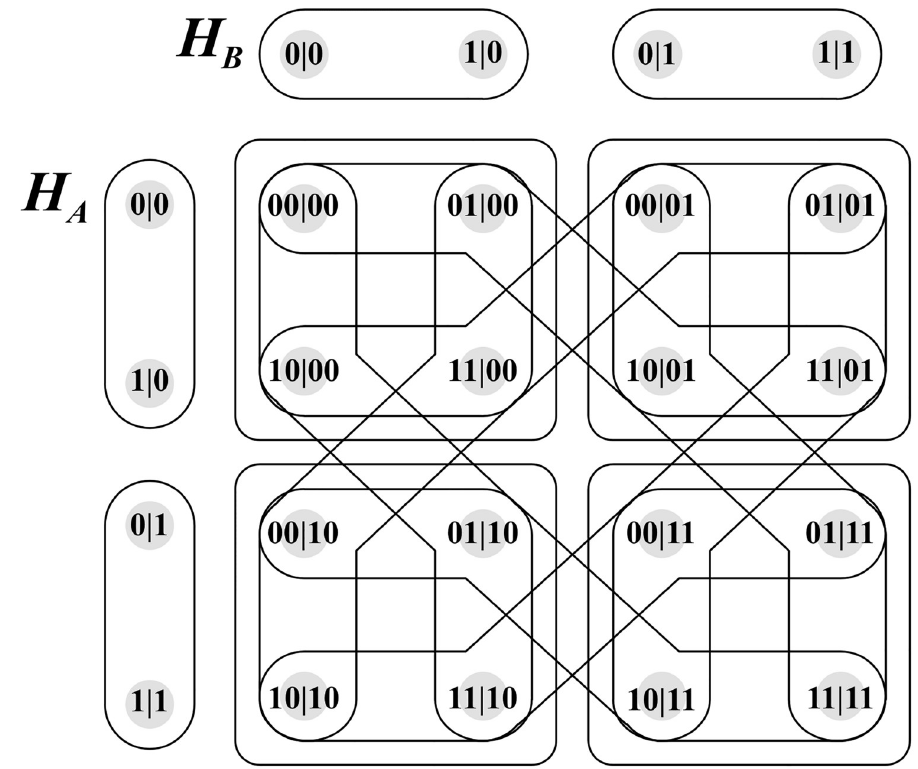
Fig 4. Hyperedges Of Foulis—Randall